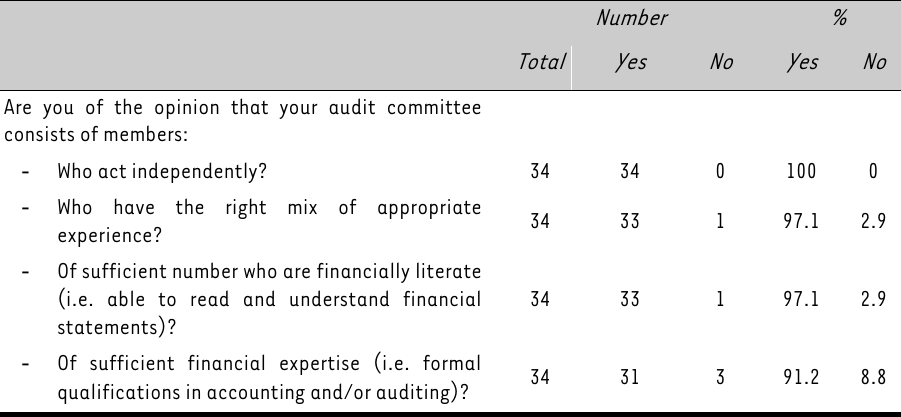
TABLE 2: Audit committee chairs’ views on the effective constitution of their audit committees